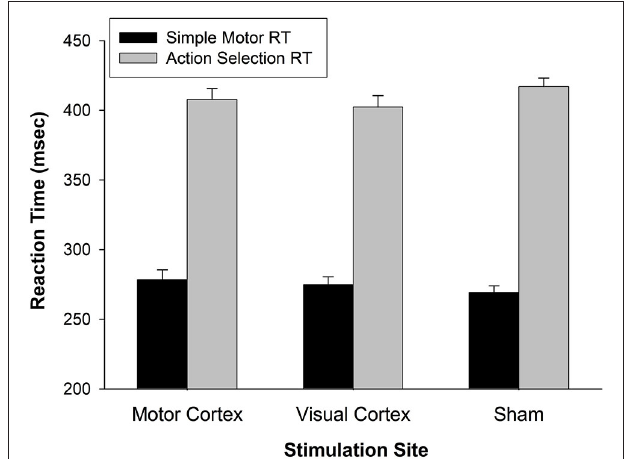
FIGURE 3 | TMS effects on accuracy . The TMS effect represents the difference between M1 and VC accuracy minus Sham accuracy. Stimulation site had no effect on accuracy across trial types. Error bars denote standard error.